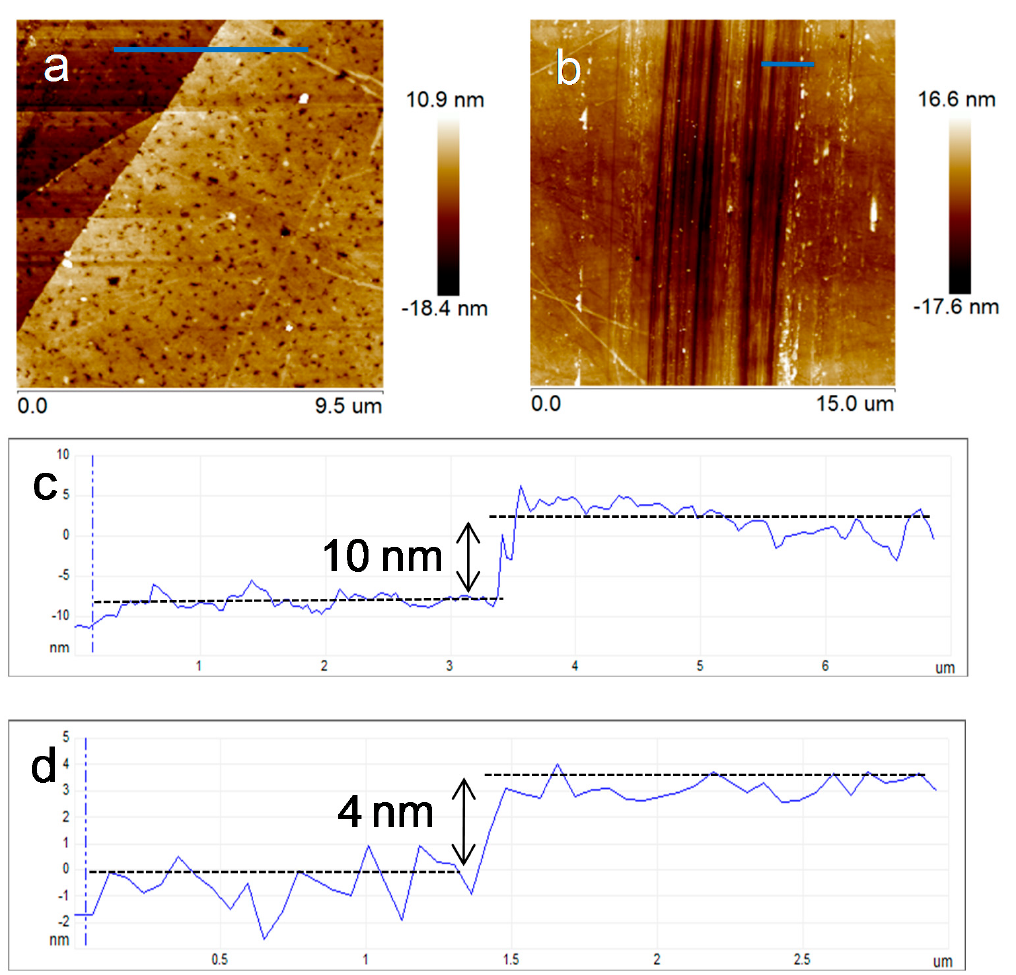
Figure 5. AFM images of two (N)G films prepared from chitosan pyrolyzed at 1100 ( a ) and 1200 °C under Ar/H 2 (5%) flow ( b ). Plots c and d show the section profiles of images ( a ) and ( b ), respectively, along the blue lines indicated in the frames ( a ) and ( b ). Thicknesses about 10 and 4 nm were determined for the films prepared at 1100 and 1200 °C, respectively.